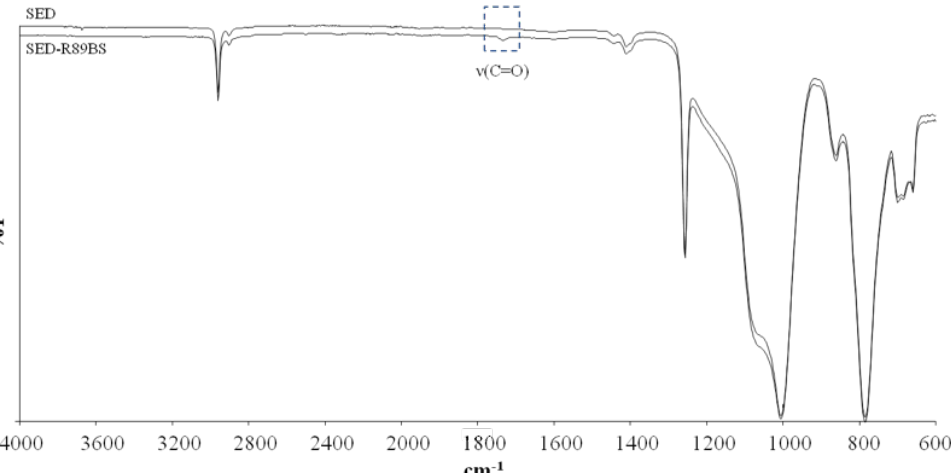
Figure 3. ATR-FTIR spectra of silicone elastomeric discs (SEDs) and SEDs coated with R89BS.